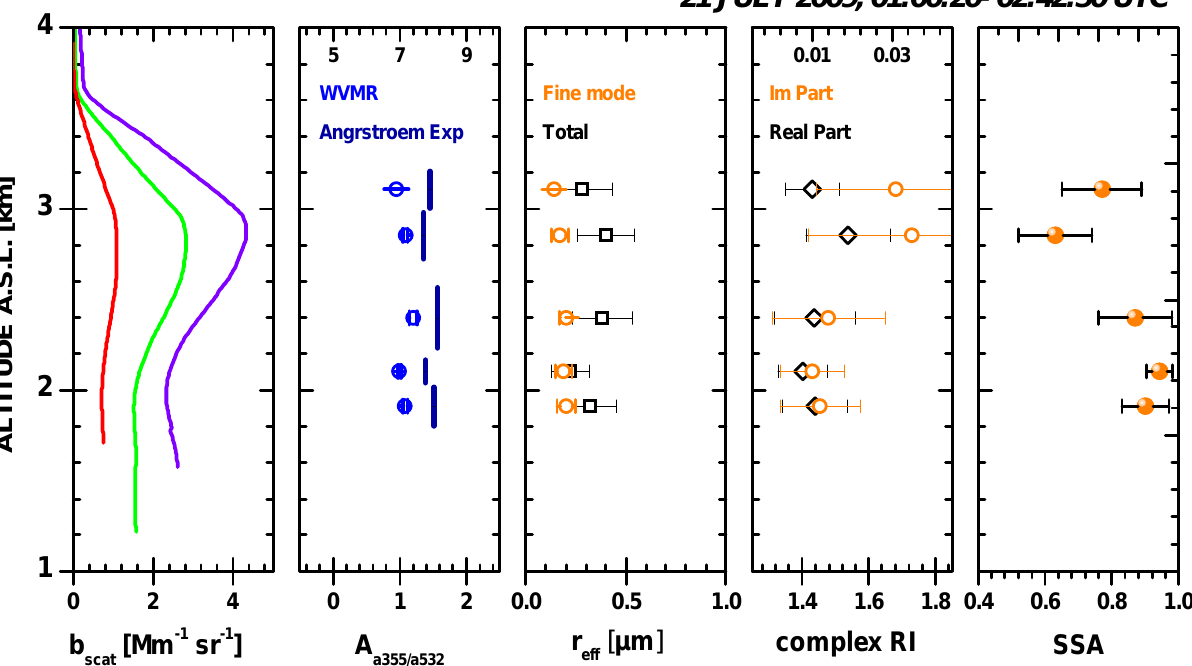
Fig. 5. Vertical profiles of the aerosol backscatter (at 355, 532 and 1064nm), the extinction-related ˚Angstr¨om exponent (355/532nm), and the mean water vapor mixing ratio, as estimated from Raman lidar measurements; the corresponding vertical profiles of the aerosol effective radius, refractive index, and the single scattering albedo, as estimated by the inversion algorithm using the aerosol optical properties derived from Raman lidar measurements at 532nm on 21 July 2009 (01:00–02:42UTC).